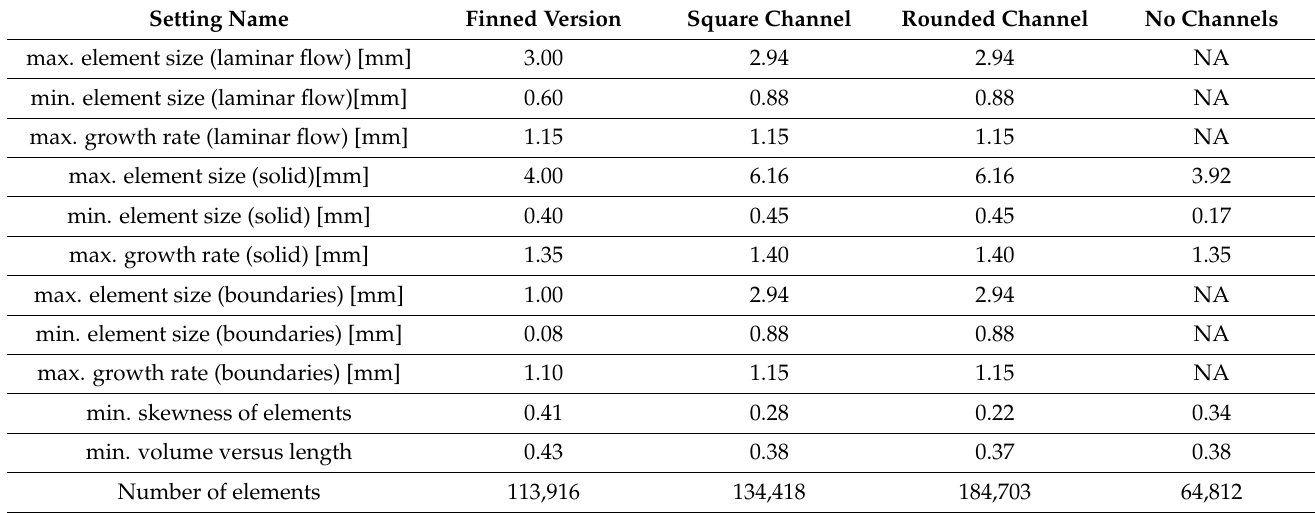
Table 2. The comparison of mesh